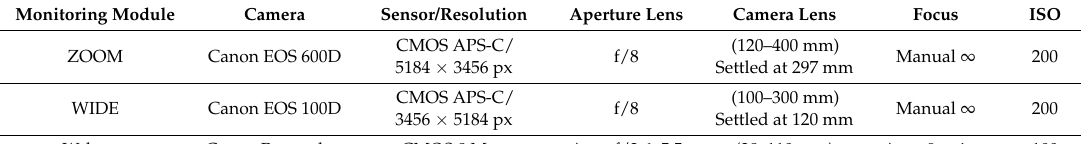
Table 1. Main characteristics of the cameras mounted in the monitoring station.